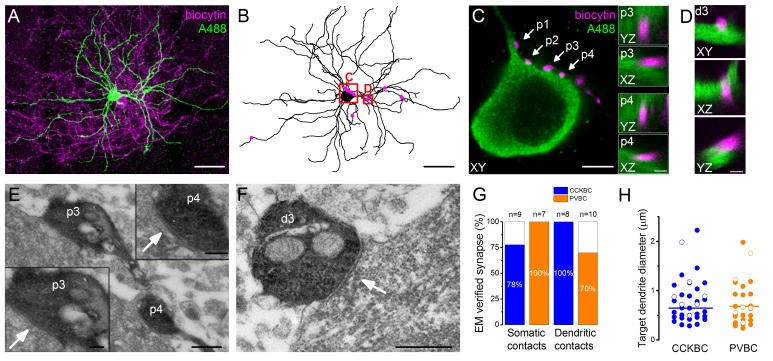
Morphological analysis of the synaptic connections in the recorded pairs.(A) Maximum z intensity projection of a 3D confocal image of a representative pair. Biocytin in the PVBC was visualized with streptavidin-conjugated Alexa 594 (magenta), while Alexa 488 in the PN is shown in green. For the differentiation of Alexa488 and eGFP signals see Figure 3—figure supplement 1. (B) Neurolucida reconstruction of the postsynaptic PN with the contact sites (magenta) originated from the PVBC. (C) High power magnification of the perisomatic region shown in B, which receives multiple contacts (arrows, perisomatic contact #1–4: p1-p4) from the presynaptic PVBC (magenta). Insets: 3D analysis of confocal images of p3 and p4 boutons shows close appositions of the pre- and postsynaptic structures. (D) High power magnification 3D confocal images of the region indicated in panel B, showing a close apposition between a dendrite-targeting bouton (d3) and a PN dendrite. (E) Electron micrographs of p3 and p4 shown in panel C. In both cases synaptic contacts with the soma of the postsynaptic PN (arrows) are visible. (F) An electron micrograph of d3 shown in panel D, confirming the presence of synaptic contact on the dendrite of the postsynaptic PN (arrow). (G) Ratio of close appositions observed at the confocal microscopic level forming synaptic contacts confirmed with electron microscopy. (H) Electron microscopic analysis of the diameters of the dendrites innervated by BCs shows that both BC types form synapses on dendrites with small and large diameters, respectively (CCKBCs: 0.79 ± 0.07 µm, n = 28, PVBC: 0.72 ± 0.08 µm, n = 36, p=0.63, K-S test). Open circles show contacts on the electrophysiologically recorded postsynaptic PNs, filled dots represent synapses on random targets of the biocytin-labeled varicosities of BCs in the sample. Scales (in µm): A and B: 50; C: 5, insets and D: 1; E: 0.5, insets: 0.2; F: 0.5. For the details of the analyzed contact numbers see Figure 3—source datas 1 and 2.DOI:
http://dx.doi.org/10.7554/eLife.20721.00710.7554/eLife.20721.008Figure 3—source data 1.Number of the pairs and analyzed contacts at the confocal microscopic level.DOI:
http://dx.doi.org/10.7554/eLife.20721.00810.7554/eLife.20721.009Figure 3—source data 2.Summary table of the contacts analyzed at the electron microscopic level.Data is shown as the number of the analyzed contacts, with the number of verified synapses shown in parentheses.